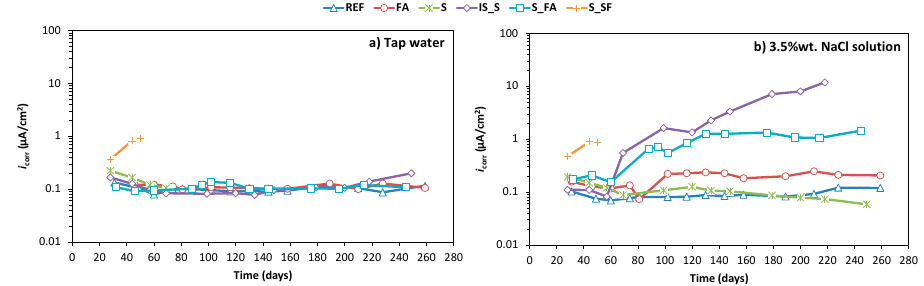
Figure 7. Current density of steel embedded in mortar immersed in ( a ) tap water and ( b ) NaCl 3.5 wt.% solution, with 7 days of curing prior to immersion or exposure.